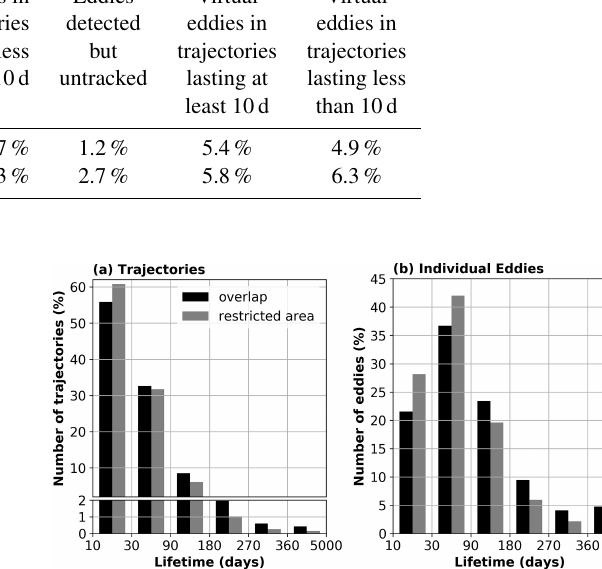
Table 1. Repartition of eddies after tracking made by the overlap or the restricted area methods. Note that percentages are obtained relative to the sum of the observations within trajectories ≥ 10d and < 10d, and the untracked eddies for the first three columns, and relative to the number of observations in the trajectories ≥ 10d and < 10d, respectively, for the last columns. Tracking Eddies in Eddies in Eddies Virtual method trajectories trajectories detected lasting at lasting less but trajectories trajectories least 10d than 10d untracked